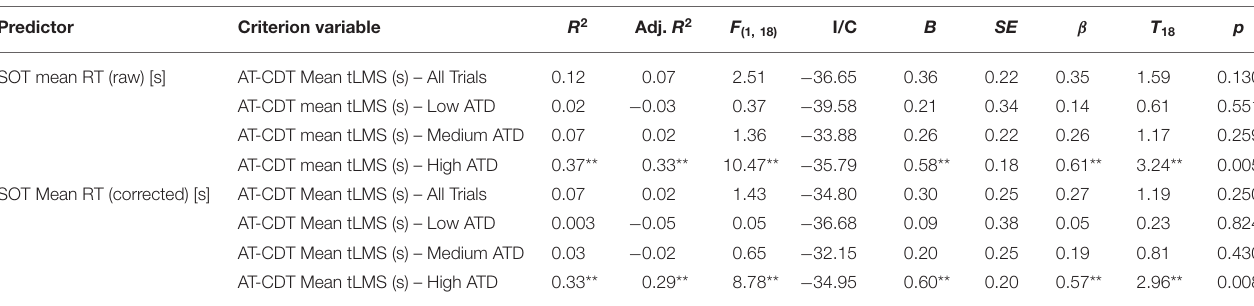
TABLE 4 | Regression of AT-CDT Mean tLMS values on SOT Mean RTs (Raw and Uncorrected).